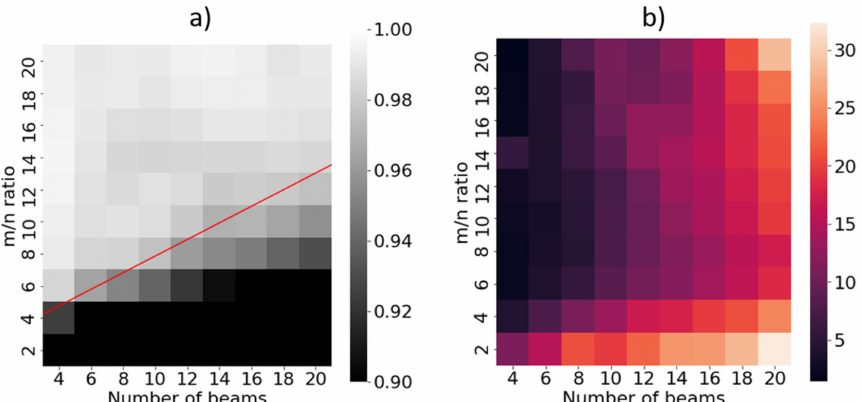
Figure 3. ( a ) Reward evolution during TANN training for 7 beams and 70 detectors with 8 corrections steps T . ( b ) Average evolution of the quality factor Q according to the phase correction iterations of the trained system (100 random initial phase sets, 7 beams, 70 detectors). The red dotted line shows the 96% threshold. On average, only 3 steps of correction are required to reach the threshold phasing quality.